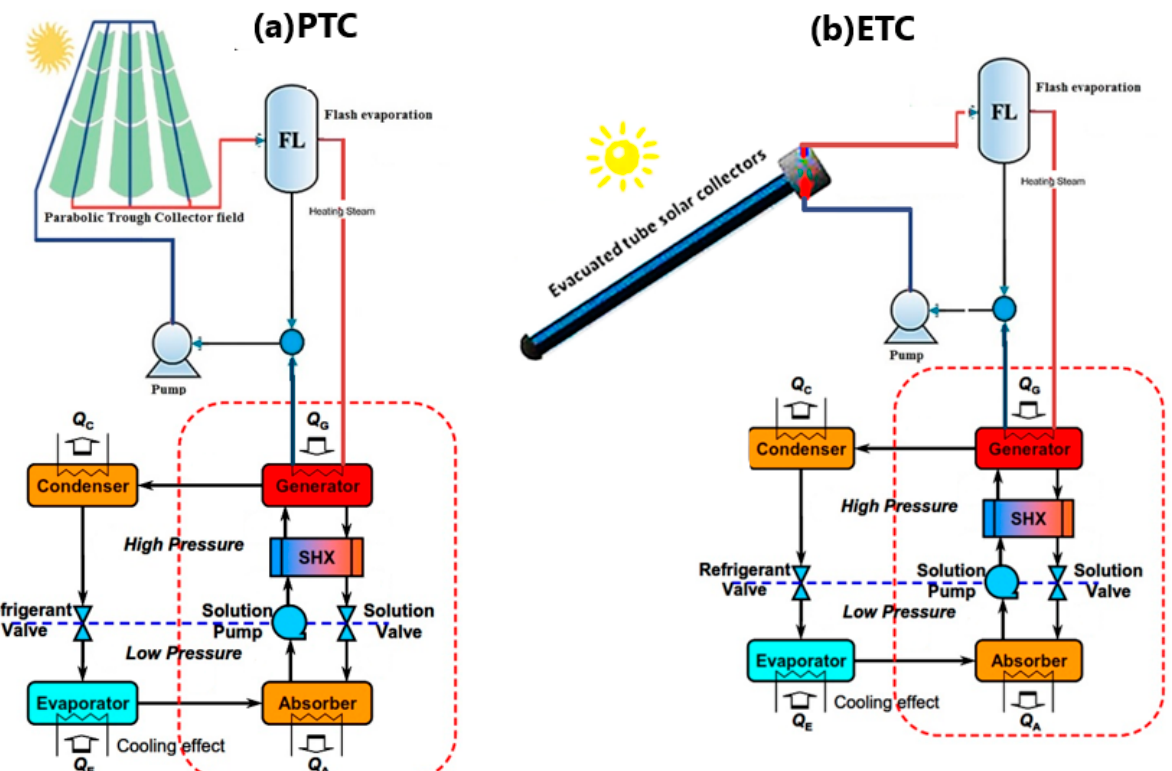
Figure 1. Absorption air-conditioning system integrated with solar thermal collector. ( a ) Parabolic trough collector PTC; ( b ) Evacuated tube collector ETC [24].